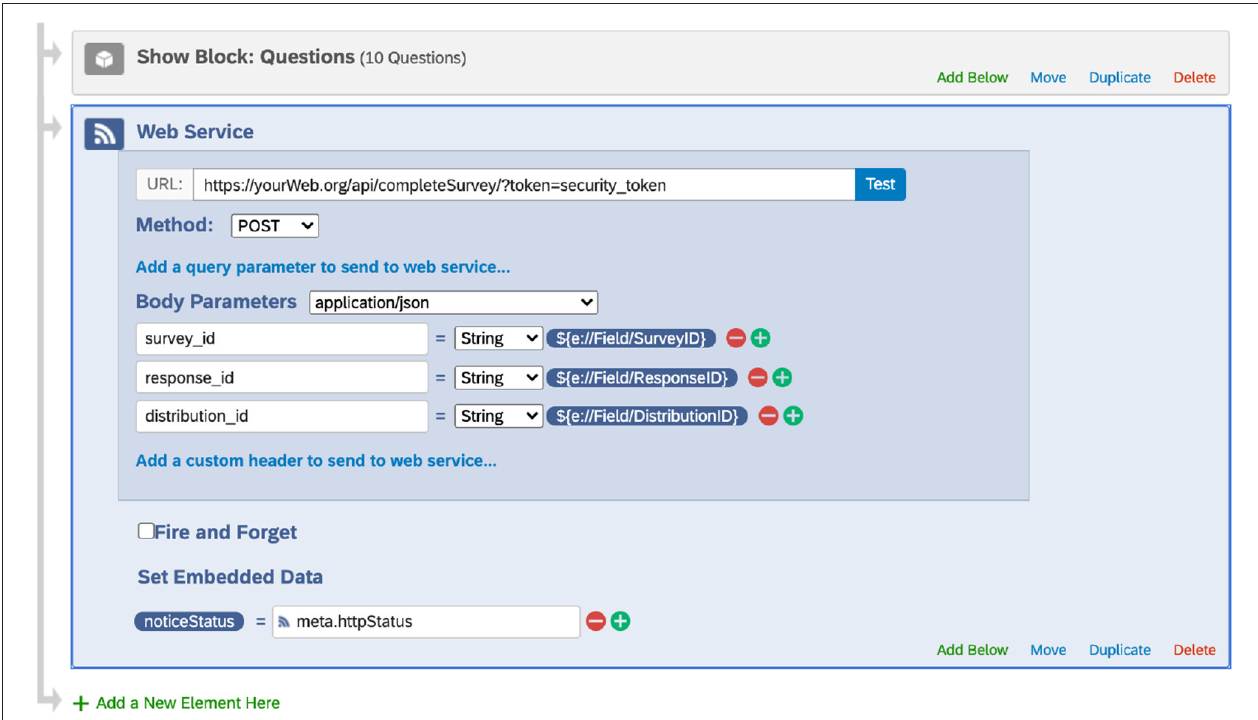
FIGURE 1 | Adding the web service element at the end of a survey (screenshot taken from the Qualtrics website under The University of Texas MD Anderson Cancer Center’s institutional Qualtrics license). This web service request sends the survey ID, response ID, and distribution ID to the database, which is used to update the Distribution table. Note that Qualtrics may update its interface.